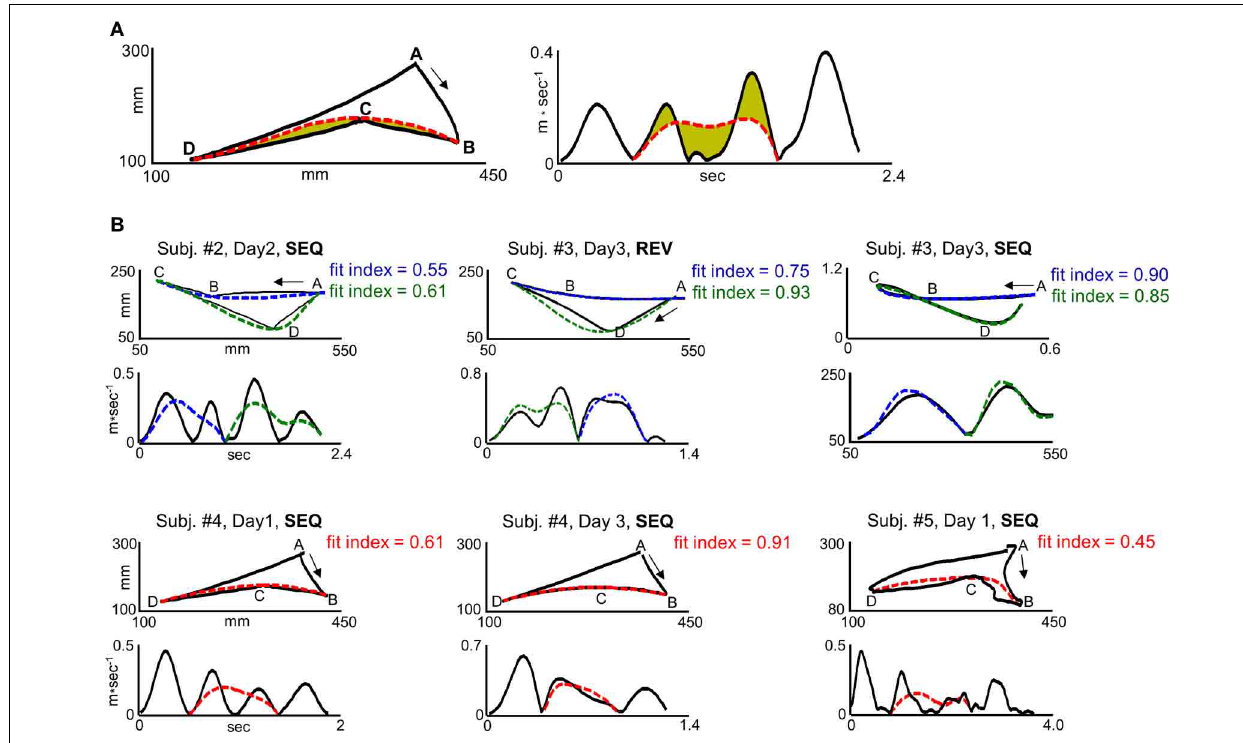
FIGURE 3 | “Global planning” model fit indices for different trajectory shapes. (A) Computation of the fit index for segment BCD in target configuration I for a representative SEQ trial in scanning day 1. I. The left plot and right plot depict path and velocity profile, respectively. The solid black curve and dashed red curve depict generated and predicted trajectory, respectively. The green colored area in the left and right plot depicts path and velocity error, respectively. The path error was normalized by the path error + lengthofthepatherrorcurve. Thevelocityerrorwasnormalized bythevelocity error + length of the velocity error curve. (B) Fit indices computed for different